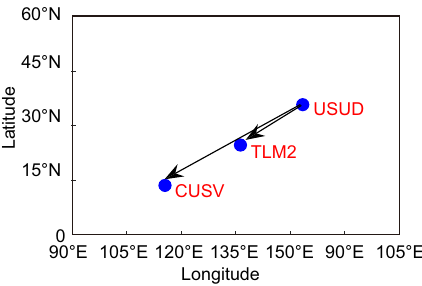
Fig. 1 CUSV and USUD stations were selected from MGEX. TLM2 was selected from a timing lab. All selected stations can be covered by the PPP-B2B service